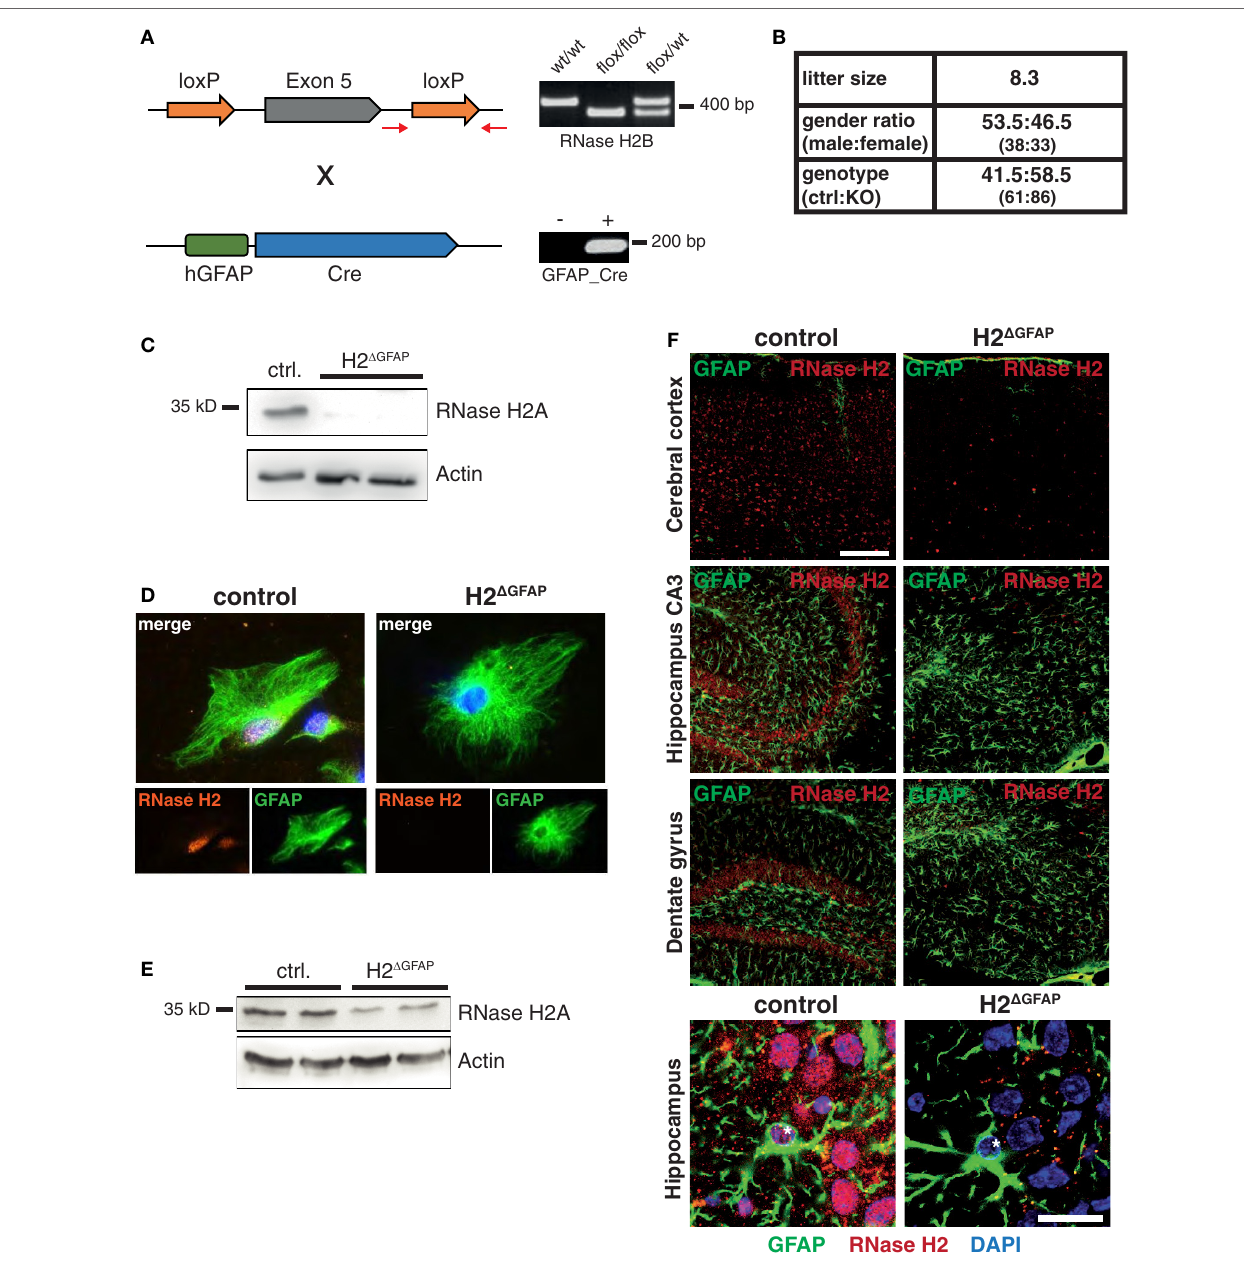
FigUre 2 | Validation of RNase H2 Δ GFAP conditional knockout mice. (a) Depiction of the relevant transgenic regions and RNase H2 Δ GFAP PCR genotyping strategy. Representative agarose gel images are shown on the right with respective genotypes above. Red arrows indicate PCR primer pair used for genotyping the floxed RNase H2B allele. (B) Breeding characteristics of RNase H2 Δ GFAP mice including litter size, gender, and genotype distribution. (c) Western Blot confirming loss of catalytic RNase H2A subunit in cultivated RNase H2 Δ GFAP astrocytes 7 days post isolation. β -actin served as loading control. (D) Representative confocal images showing lack of RNase H2 holo enzyme in RNase H2 Δ GFAP astrocytes 7 days post isolation. Astrocytes stained positive for GFAP, while DAPI was used as nuclear counter stain. (e) Immunoblot showing reduced RNase H2A protein levels in whole brain lysates of RNase H2 Δ GFAP mice (age 8 weeks, two mice per genotype). β -actin as loading control. (F) Absence of RNase H2 holoenzyme in the majority of cells in the cerebral cortex, hippocampus (CA3), and dentate gyrus of RNase H2 Δ GFAP mice (age 3 months). Astrocytes were co-stained with GFAP, while nuclei were counter-stained with DAPI. Note the absence of RNase H2 in both astrocytes (asterisk) and neuronal cells (lower panel). Scale bars = 150